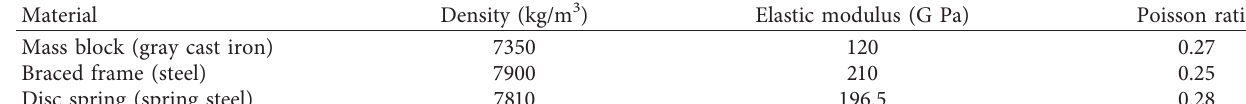
Table 1: Material parameters of the finite element model.